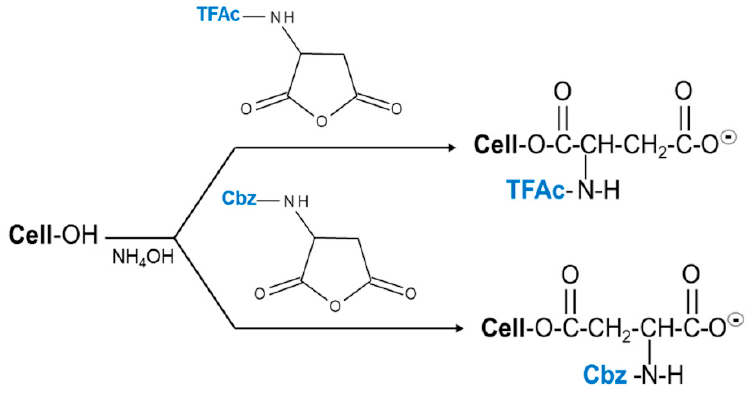
Figure 7. AsparticanhydrideswithN-protectivegroup: ( 1 )Trifluoroacetyl(TFAc)and( 2 )carbobenzyloxy(Cbz). Figure 7. Aspartic anhydrides with N-protective group: 1 ) Trifluoroacetyl (TFAc) and 2 ) carbobenzyloxy (Cbz).